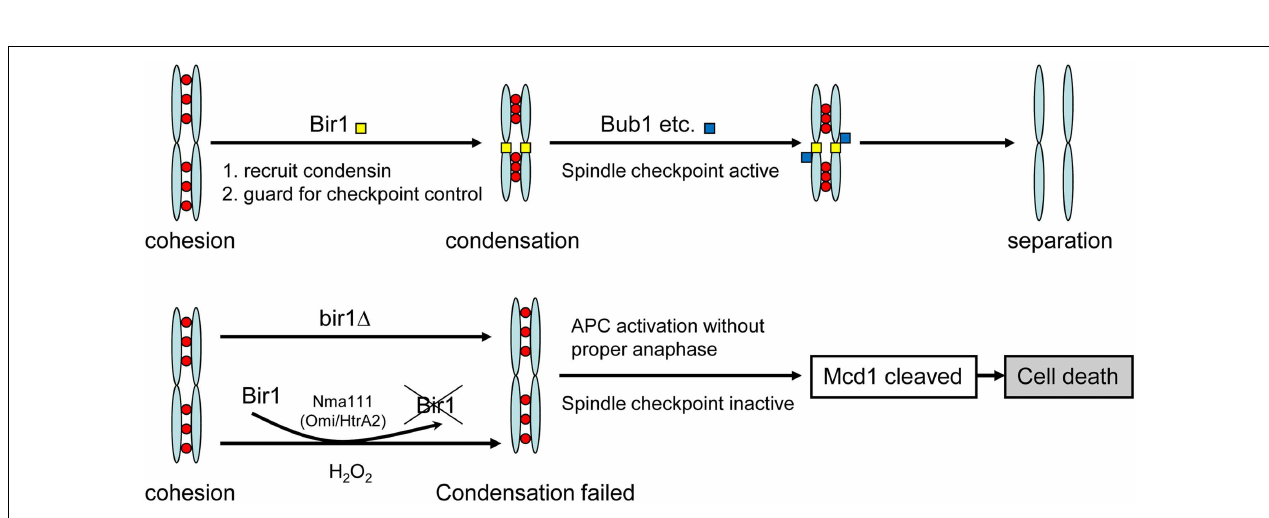
FIGURE 6 | Bub1 fails to be localized on centromeres in the presence of H 2 O 2 or bir1 deletion. Wild type (WT) cells were grown inYPD to log phase. Four millimolars of H 2 O 2 was added to the medium for 1˚h (WT + H 2 O 2 ); or Bir1-degron strain was grown to log phase at the non-inducing condition